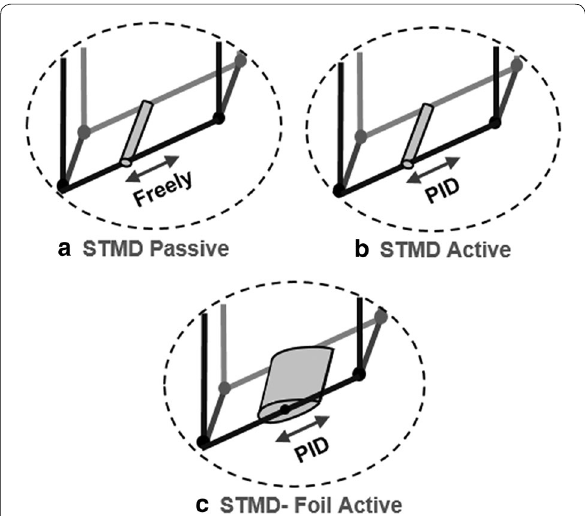
Fig. 5 Schematic concept of controlling strategies. a A thin rod-shaped slider moves along the submerged STMD’s frame with no control. b A thin rod-shaped slider moves along the submerged STMD’s frame with a PID controller. c A foil-shaped slider moves along the submerged STMD’s frame with a PID controller